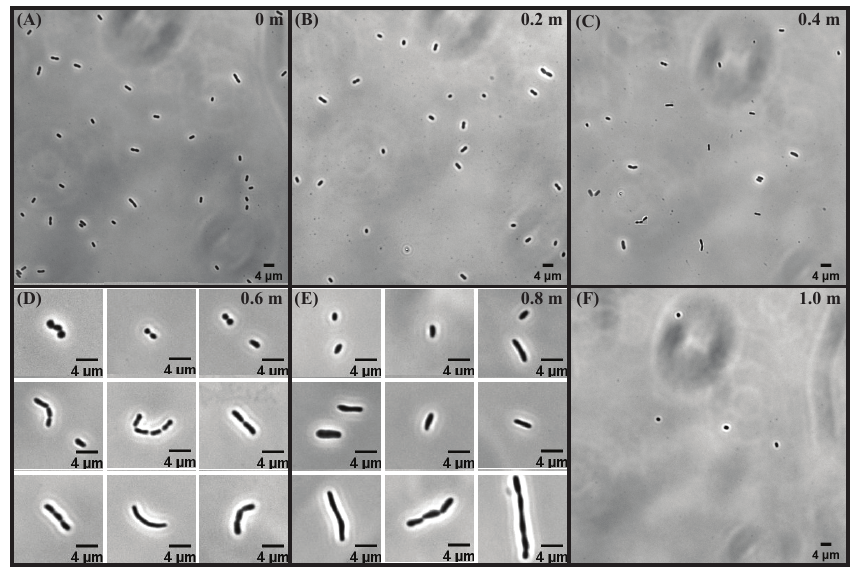
Figure 4. Representative images of cells at different concentrations ( A ) 0 m (control), ( B ) 0.2 m, ( C ) 0.4 m, ( D ) 0.6 m, ( E ) 0.8 m, and ( F ) 1.0 m of Na 2 SO 4